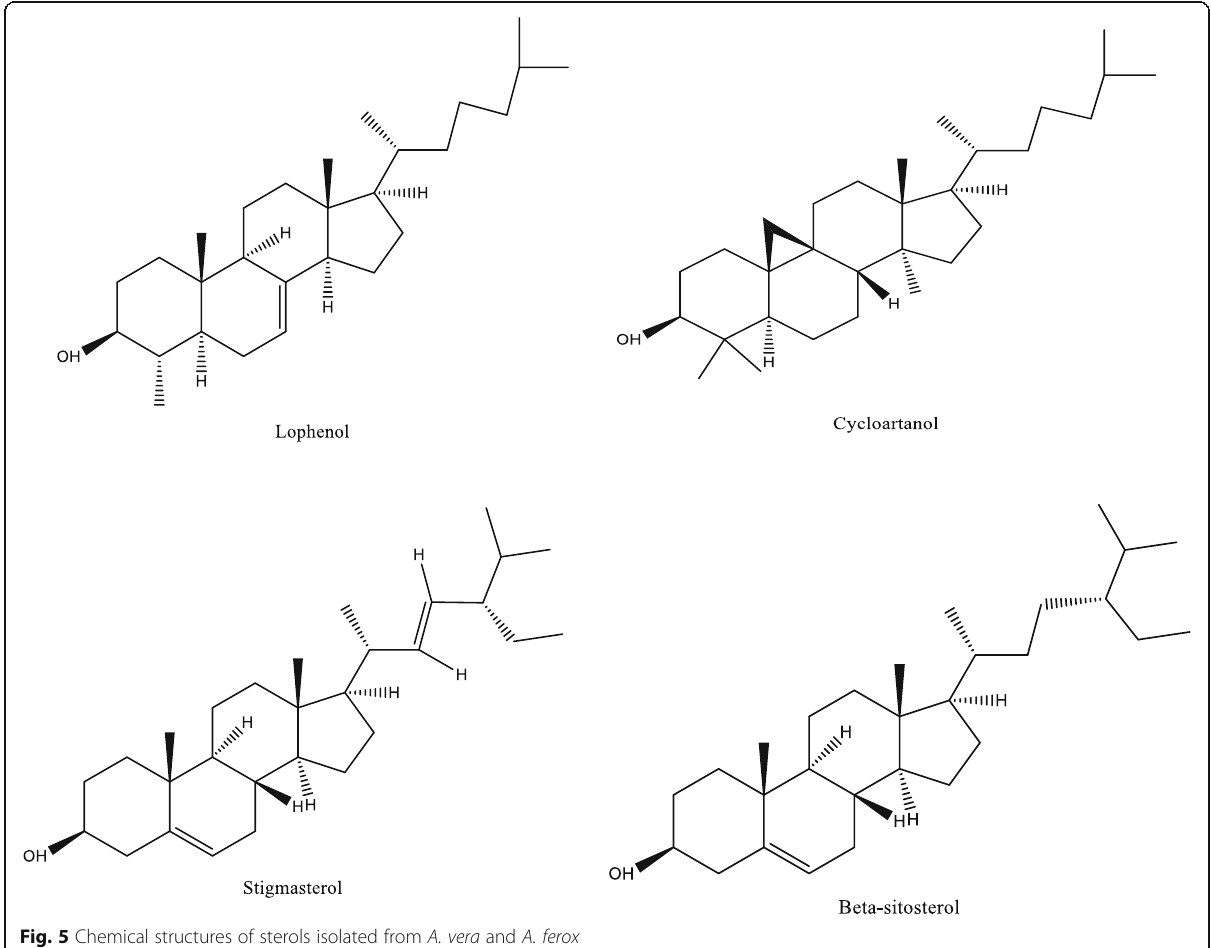
Fig. 5 Chemical structures of sterols isolated from A. vera and A. ferox